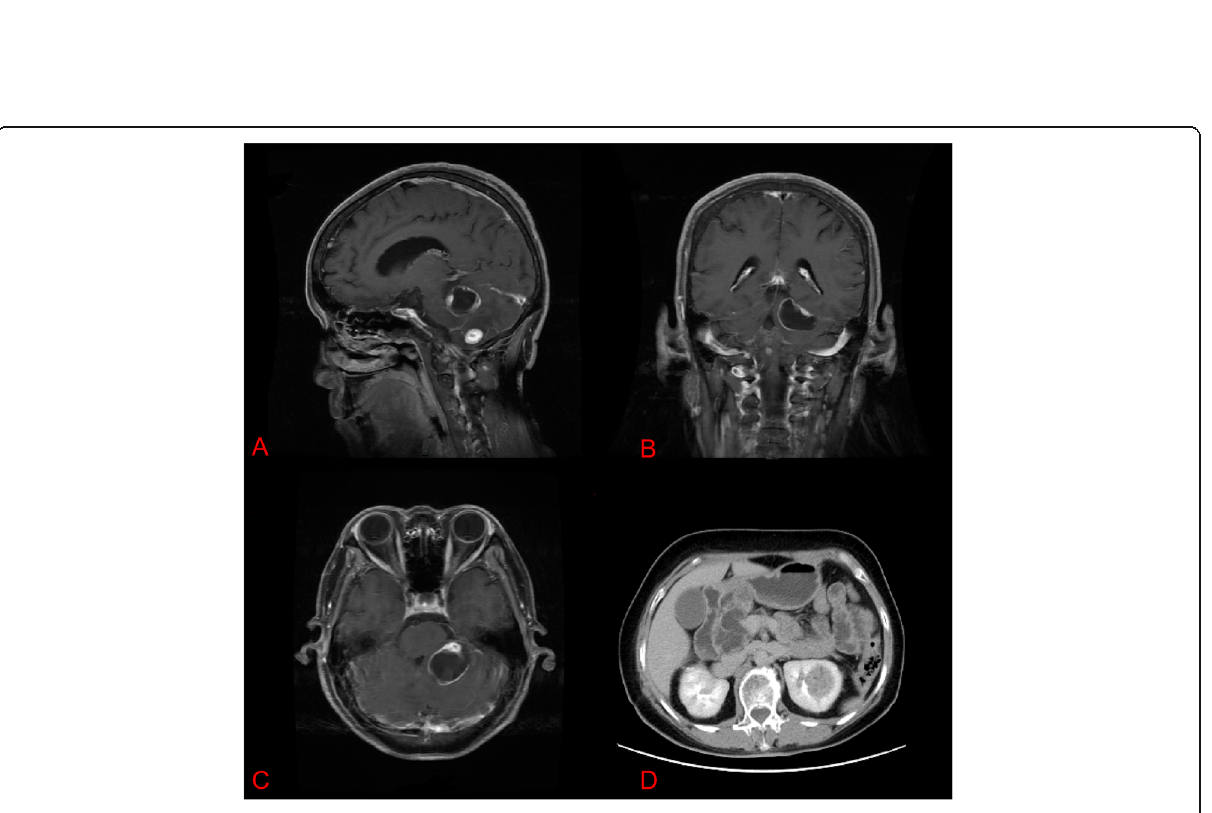
Fig. 2 a – c Contrast-enhanced magnetic resonance imaging (MRI) of the cerebellum hemangioblastomas in the 58-year-old female patient. d. Abdominal computed tomography (CT) scan with contrast demonstrated renal cell cancer and multiple renal and pancreatic cysts in the same